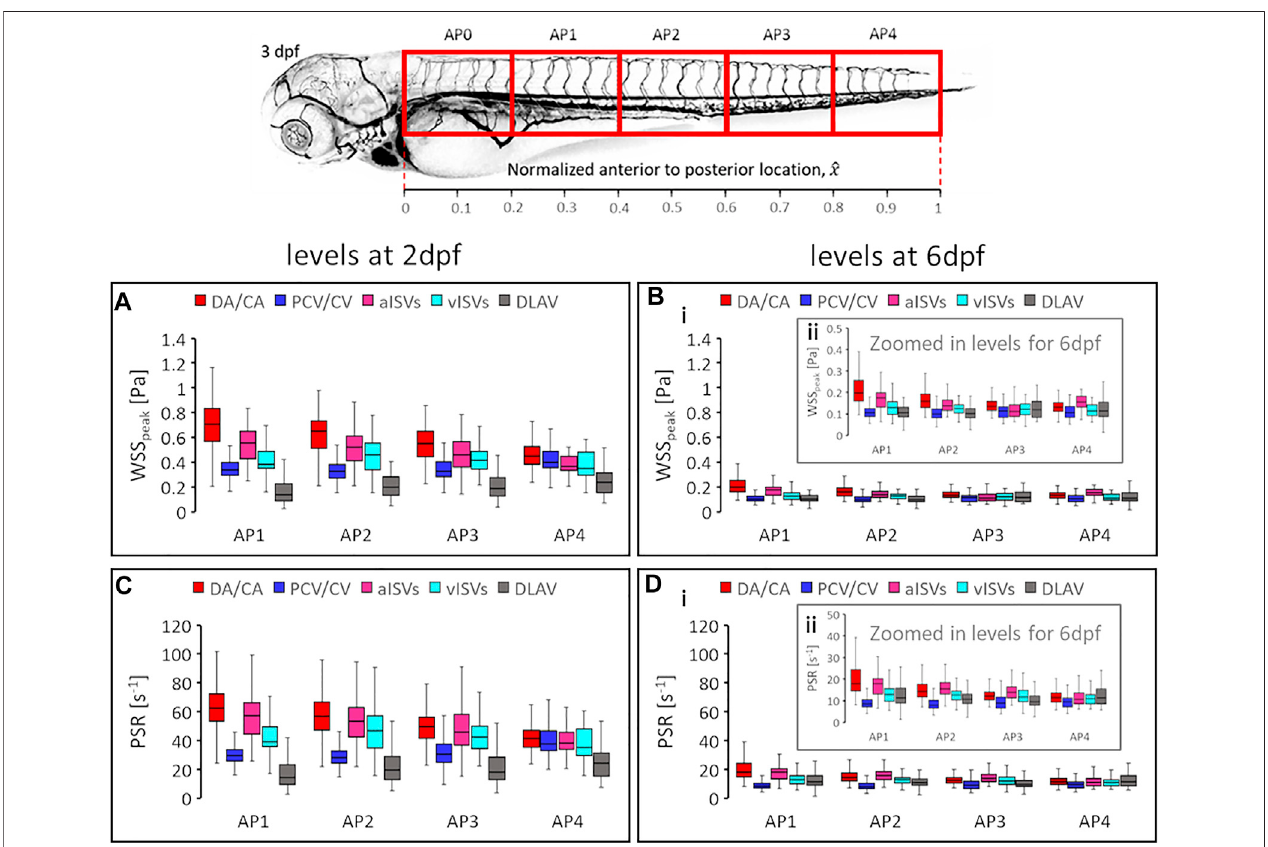
FIGURE 10 | Developmental changes in magnitude levels of shear rate related quantities. The WSS peak and its hierarchy order among vessel types are shown for 2 dpf (A) and6 dpf (Bi , ii) .The PSR anditshierarchyorderamongvesseltypesareshownfor2 dpf (C) and6 dpf (Di,ii) .Boxplotsingraphsshowthemedianandthe fi rst (Q1) and third (Q3) quartile levels of the hemodynamic quantity for the pooled zebra fi sh data. The whisker bars represent the maximum and minimum ranges of the data that lie within 1.5 times of the interquartile range (IQR = Q3 − Q1) beyond Q1 and